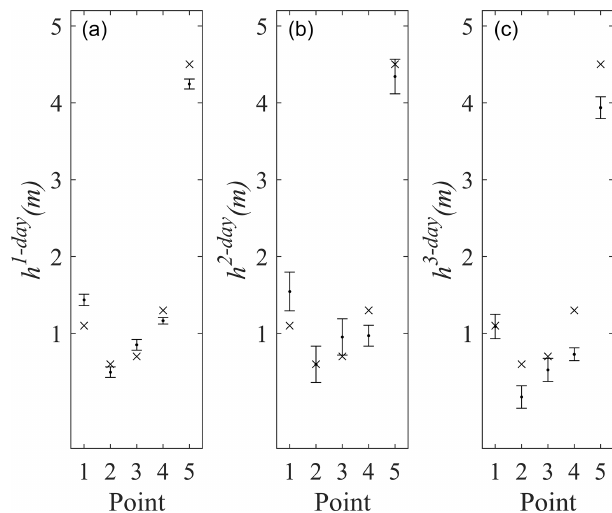
Figure 7. Comparison between water depth ( h in metres) between the numerical model ( · ) and the field data ( × ) for the three forecast windows 1d (a) , 2d (b) and 3d (c) . The range of the numerical val- ues corresponds to 3 times the standard deviation of the elevations obtained from 12:00 to 16:00 on 20 January